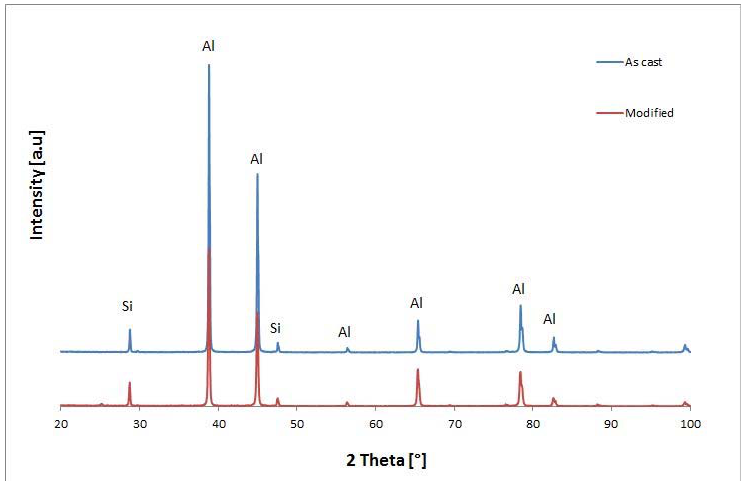
Figure 8. X ‐ ray diffraction (XRD) patterns of Al 356 alloy before and after the modification process by the modifier based on the mixture of ultrafine oxide powders.